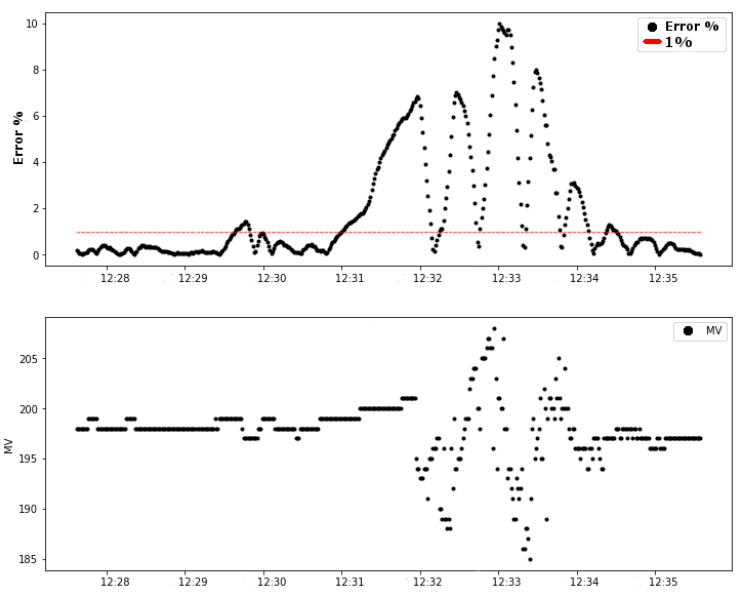
Figure 10. Test 02: variables of the control loop (error and